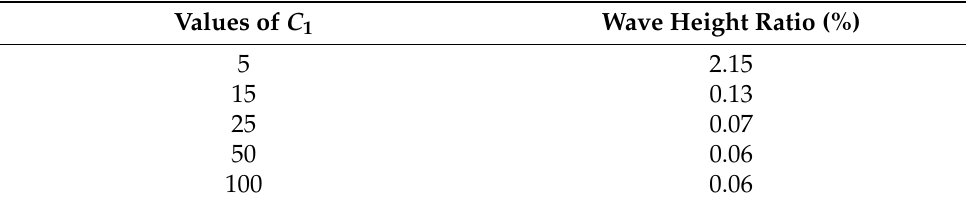
Table 3. Wave height ratio for each value of linear damping coefficient